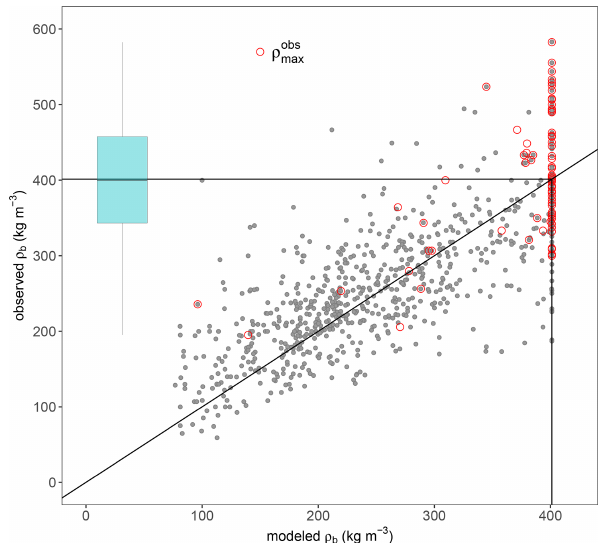
Figure 6. Scatter plot of all modeled bulk snow densities ρ b ver- sus all observed ρ b from the validation dataset. (SWE val , 767 data pairs. Seven observations, which are higher than 600kgm − 3 , were ignored.) Red circles reflect the 71 observed yearly maxima ( ρ obs max ), most of them occur when also modeled snowpack is at ρ max = 401kgm − 3 . The box plot shows the distribution of ρ obs max with me- dian, 25% and 75% percentiles, and whiskers at 1.5 times the in- terquartile